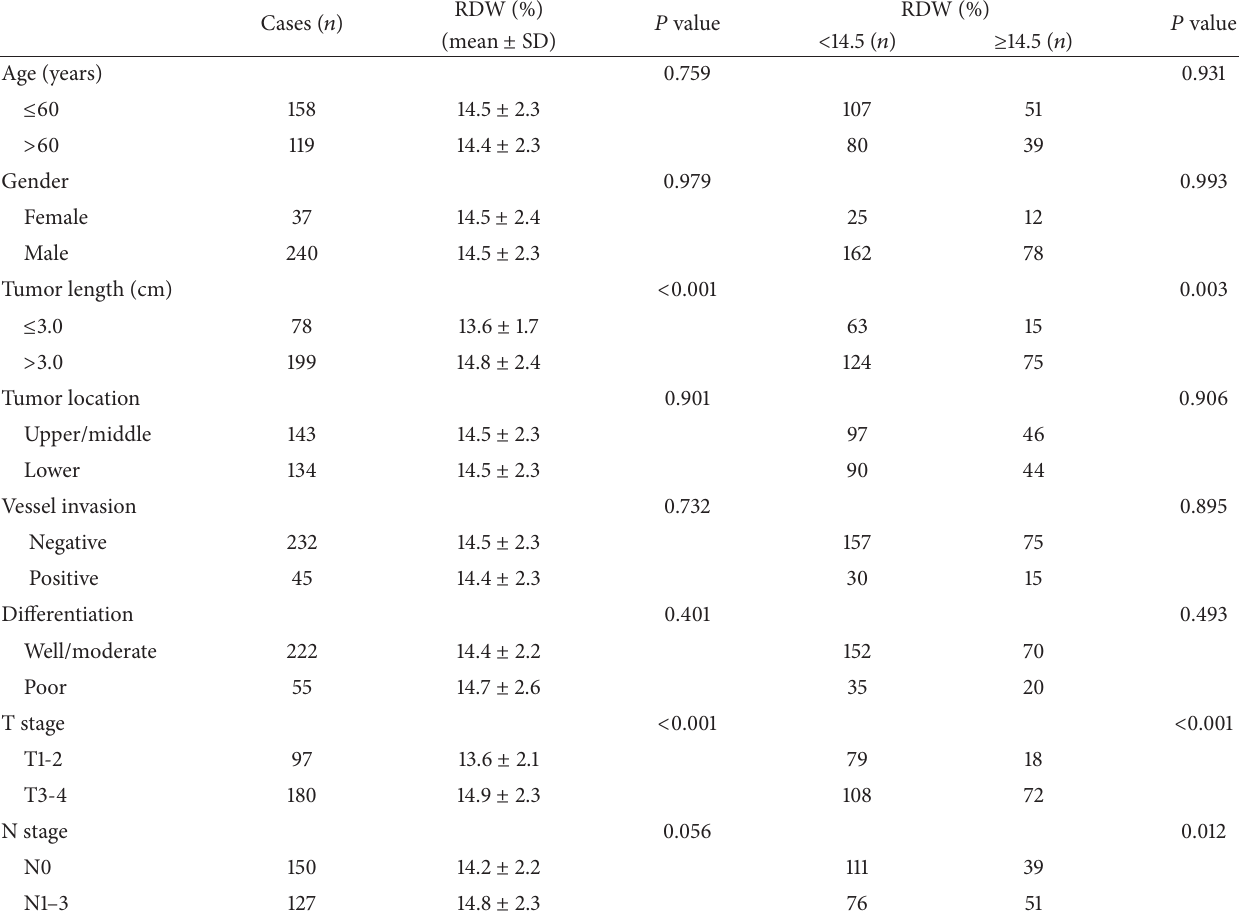
Table 1: Comparison of baseline clinical characteristics based on